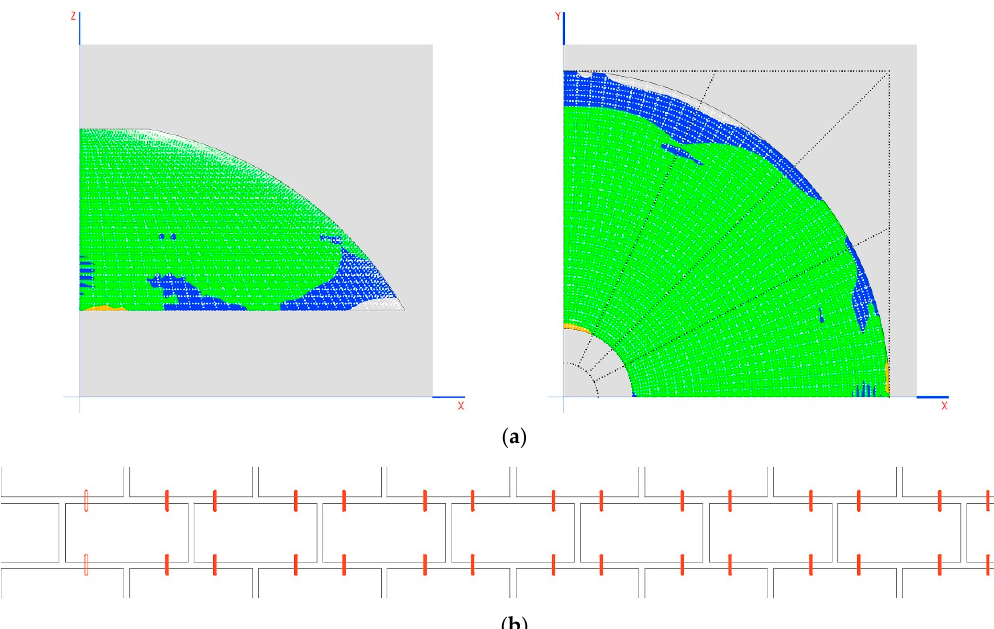
Figure 16. ( a ) Main tension is in the direction of the horizontal plane; ( b ) increased tensile strength with metal connectors placed as shown.